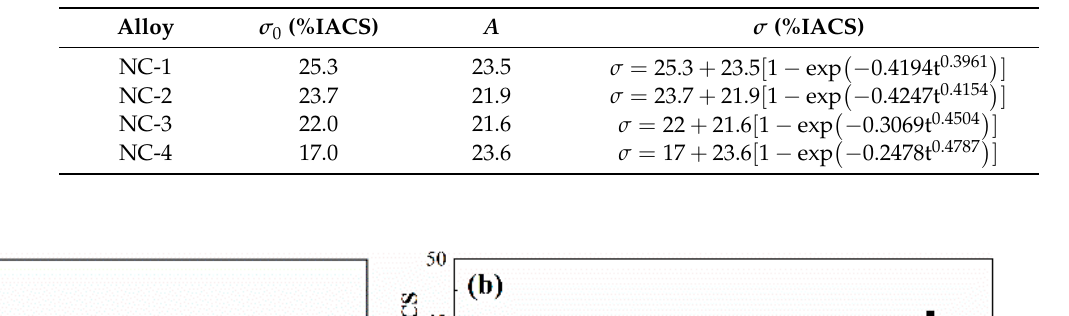
Table 9. The conductivity equation of alloys aged at 500 ◦ C.